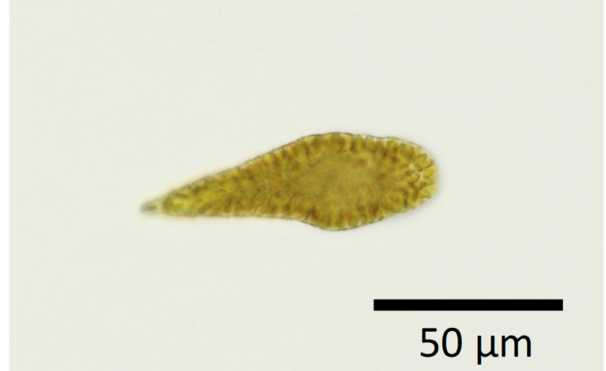
Figure 1. An image of Chattonella marina var. antiqua